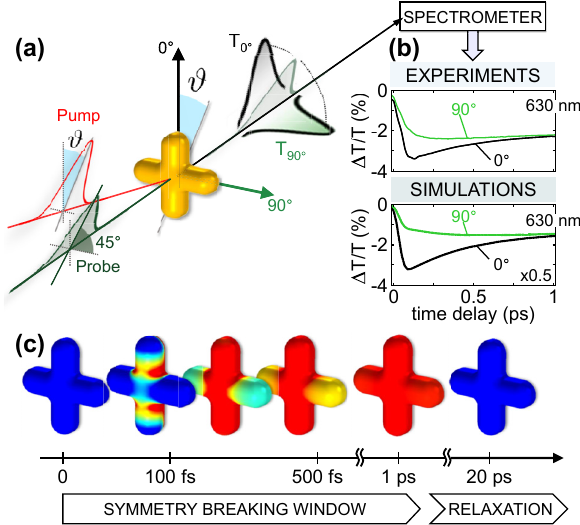
Figure 8: Design of a plasmonic metasurface for ultrafast symmetry breaking. (a) Sketch of our design concept, using a linearly-polarized pump pulse with fixed polarization angle 𝜗 , and probe pulses with linear polarization at 45 ◦ to the nanocross arm, analyzed along directions at 0 ◦ (black) and 90 ◦ (green). Adapted with permission from ref. [223].